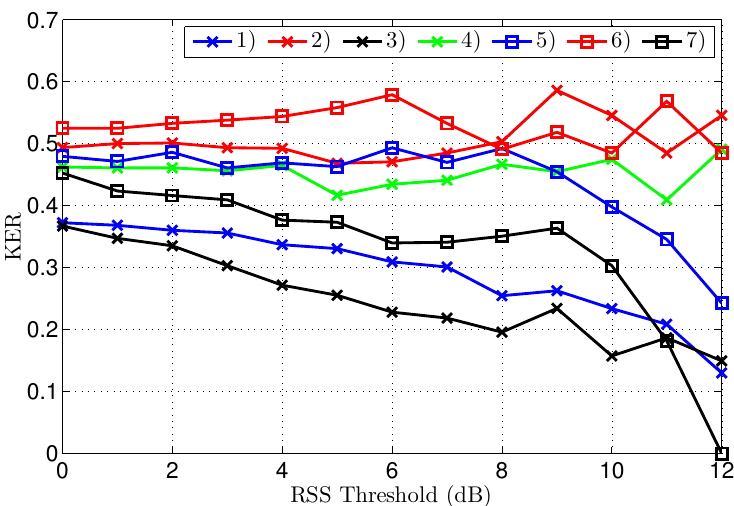
Figure 9. Key Error Rate after reconciliation for different threshold levels, for all scenarios.